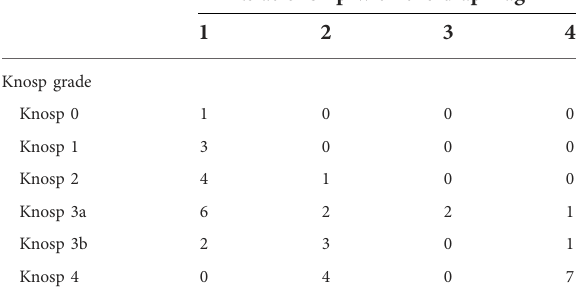
TABLE 3 The distribution of the different Knosp grades was detailed according to the relationship between the tumor and the diaphragm.